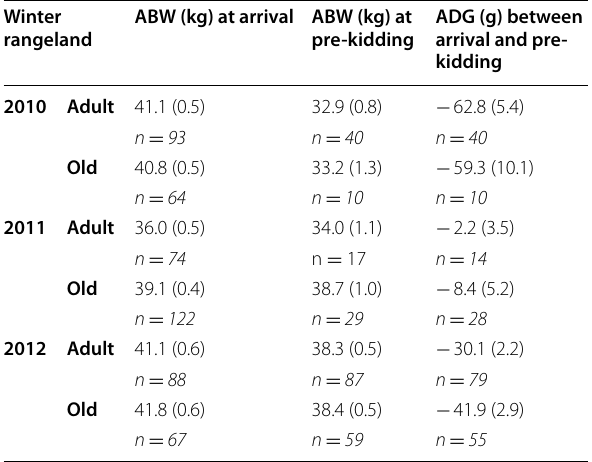
The number of evaluated goats is in italics. The standard error of the mean is between the brackets. ABW average body weight, ADG average daily gain Table 4 Average body condition score of goats at arrival to the winter rangelands and at pre-kidding and the average of the differences between them